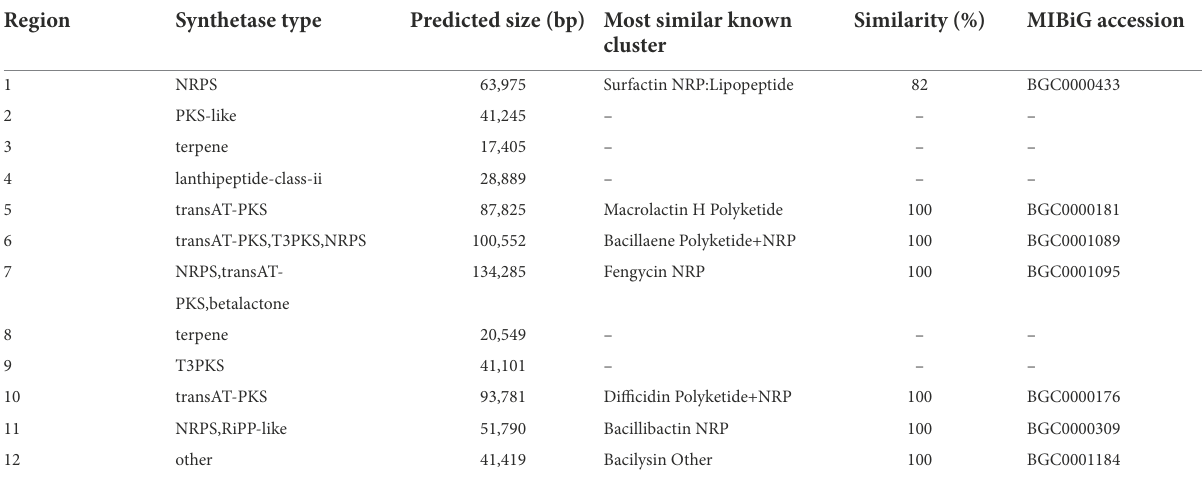
TABLE 4 Analysis of secondary metabolite biosynthetic gene clusters (BGCs) in strain E.